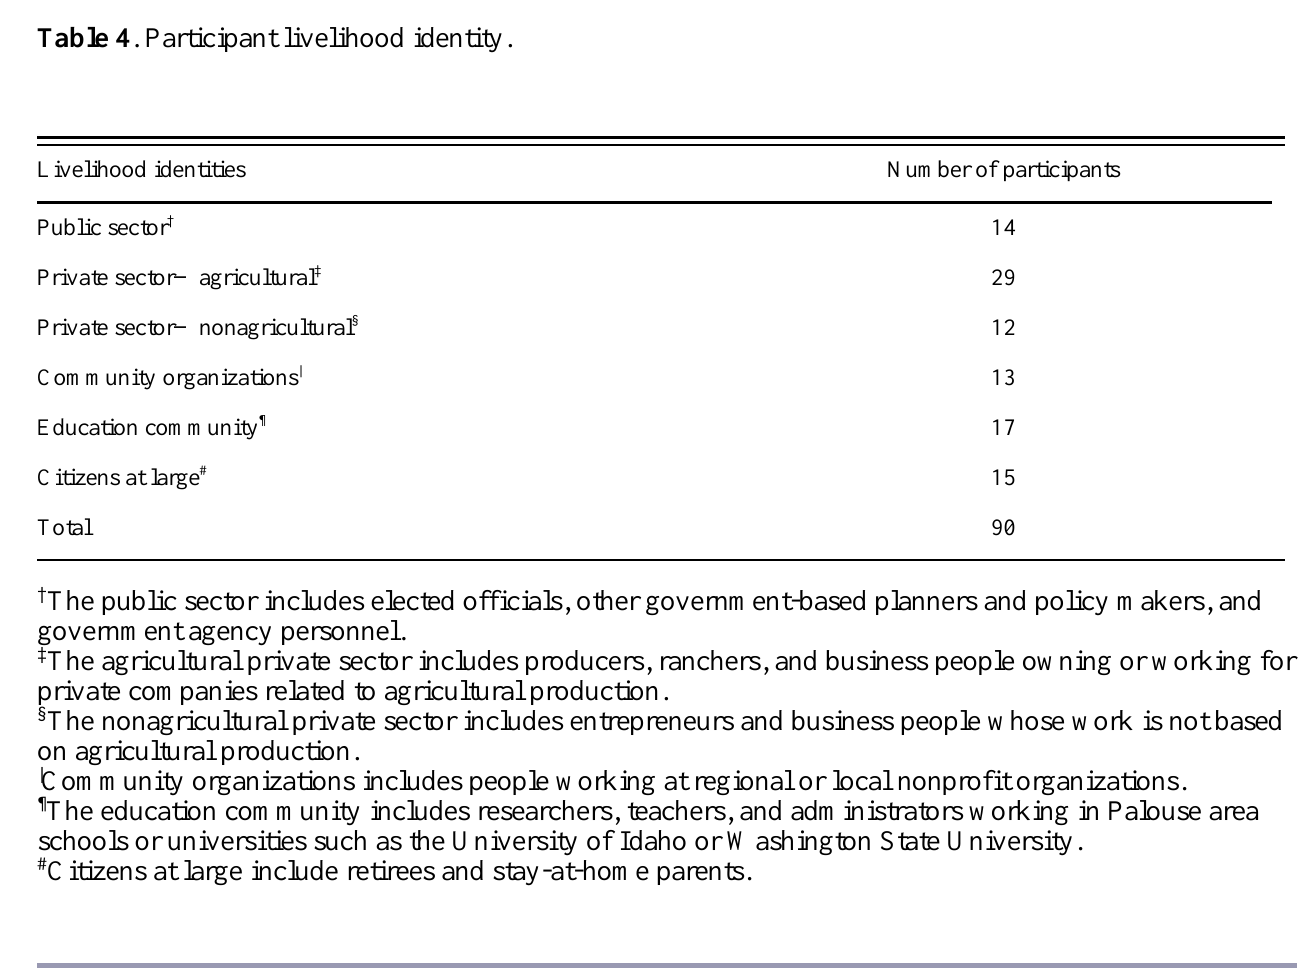
Table 4 . Participant livelihood